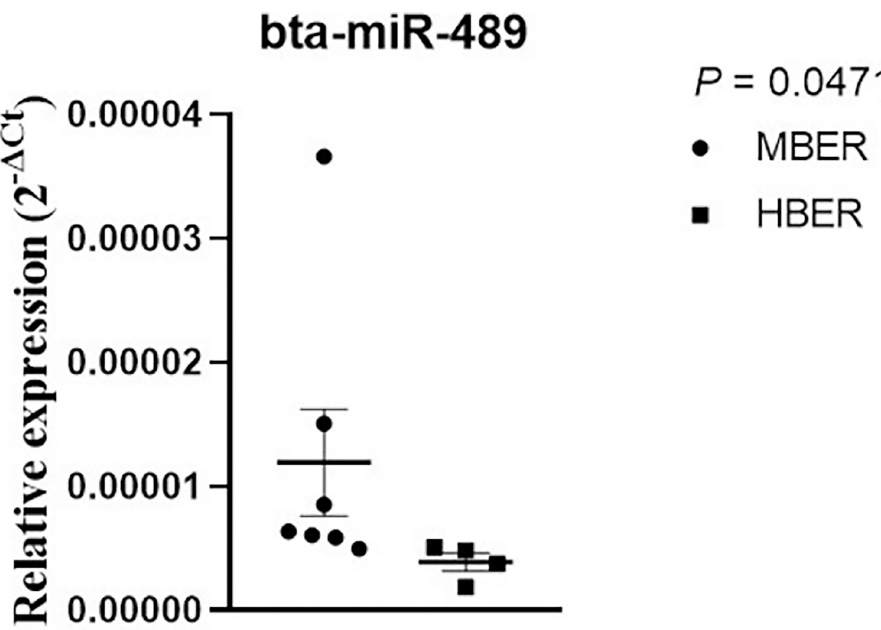
Fig 4. Relative expression of bta-miR-489 which is higher in the follicular fluid extracellular vesicles in MBER group. Mean ± standard error of the mean. P-value is in bold on the right top of the figure. follicle at D0 OV (MBER: n = 8; HBER: n = 4; S3 and S4 Tables). The mean repeatability of the samples in CC was 0.77 and 0.81 for the MBER and HBER groups, respectively, while in the